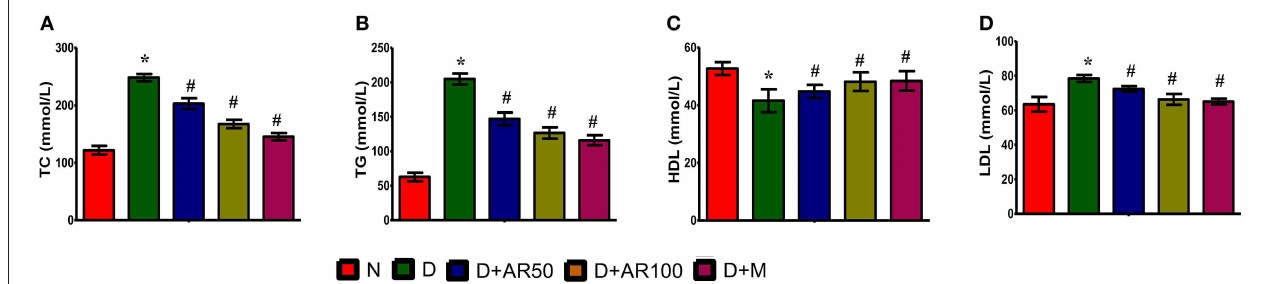
FIGURE 3 | Effect of Annona reticulata L on (A) Total cholesterol (TC) (B) Triglycerides (TG) (C) High-density lipoprotein (HDL) and (D) Low-density lipoprotein (LDL). Each value is mean ± SD of six rats in each group.*significant compared to normal control group p < 0.01. # significant compared to diabetic group p <